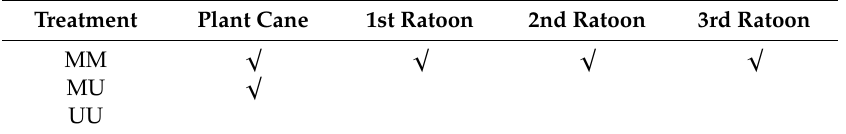
Table 1. Polyethylene mulch treatments for sugarcane production in field